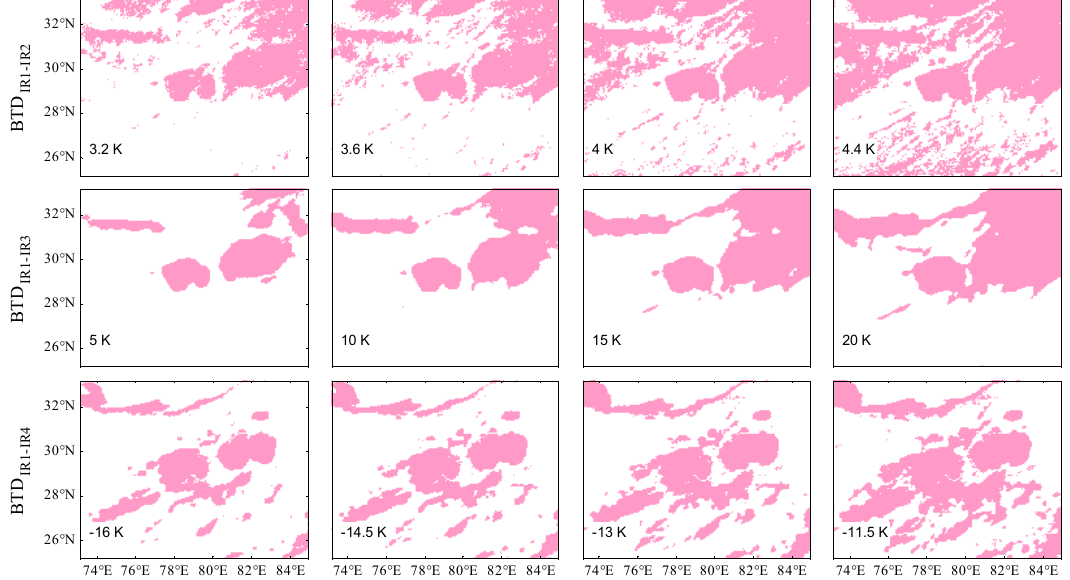
Figure 3. Results of convective cloud detection by infrared BTD thresholds.